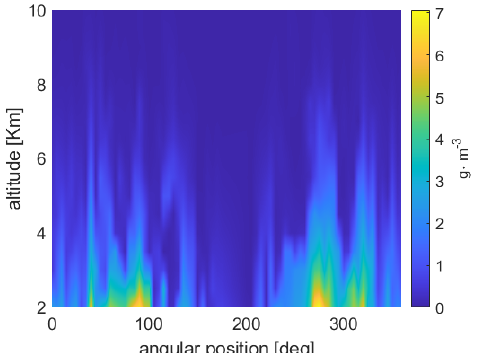
Figure 6. Original atmospheric WV map. The field (in polar format) represents an entire annular region, corresponding, approximately, to the orbital plane during a revolution of the satellites. It is shown here as a rectangular grid, in which the x -axis and the y -axis refer to the angular position and to the altitude,